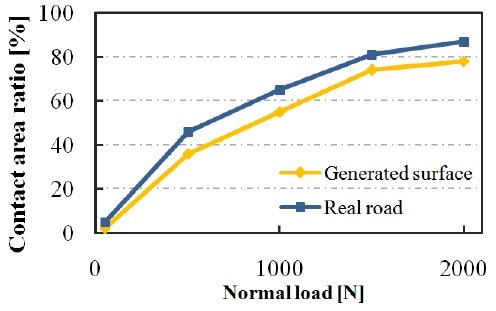
Figure 7. Load and the contact area.